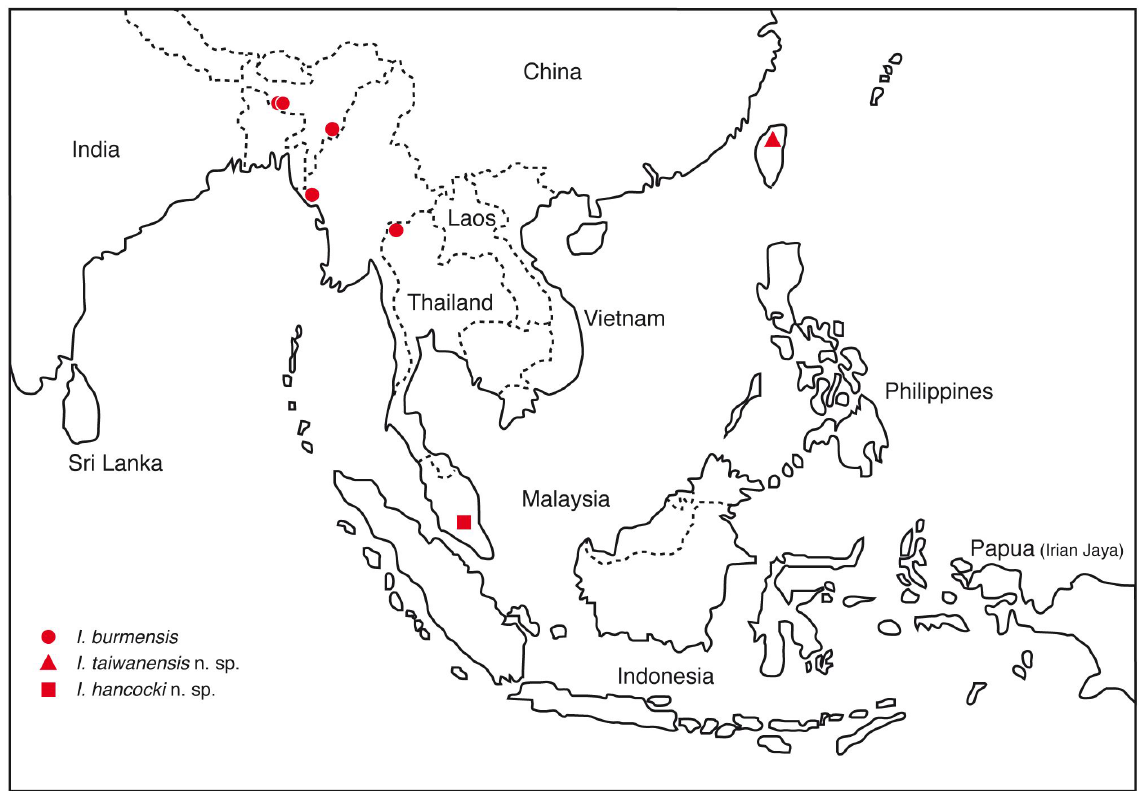
Fig. 1. Collecting localities of Ichneumonopsis